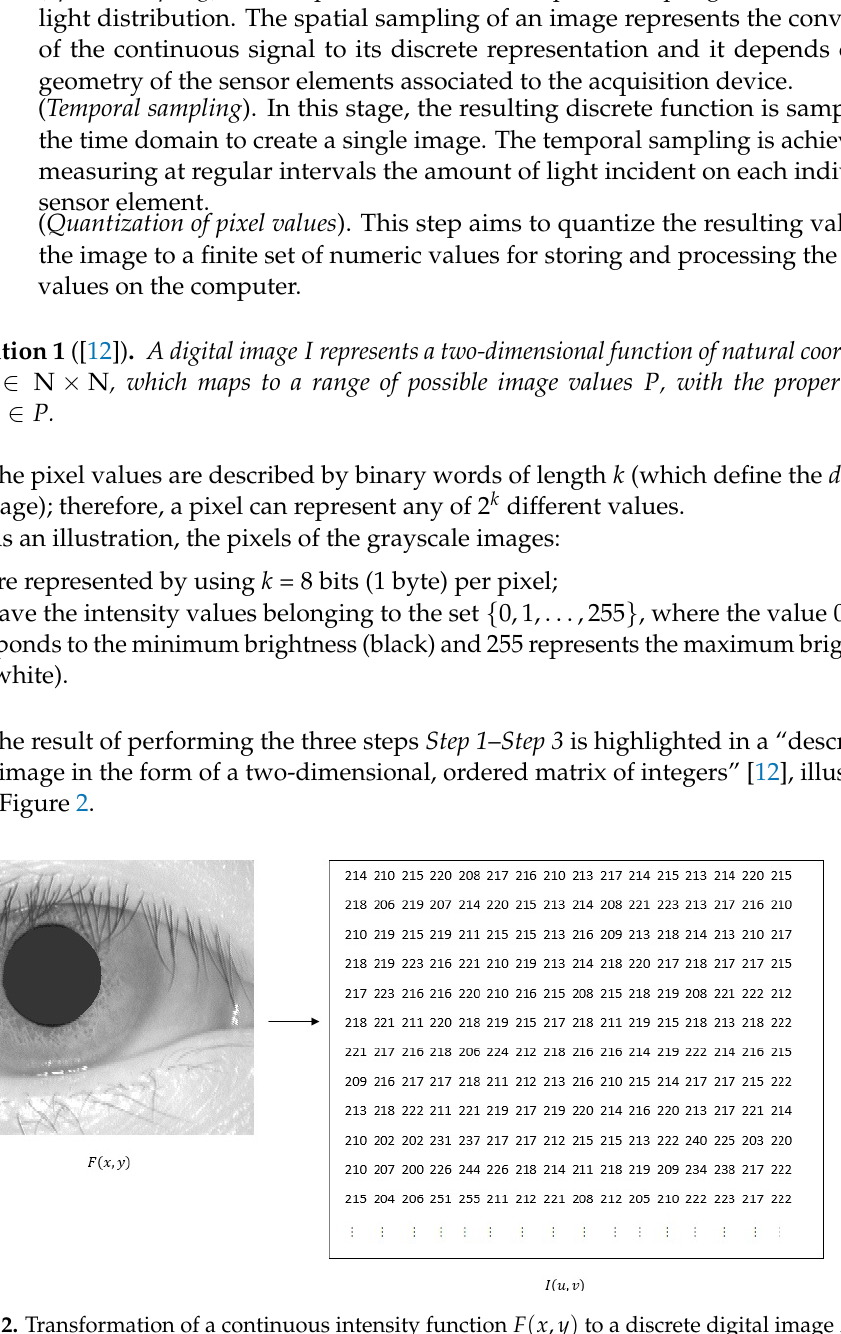
Figure 2. Transformation of a continuous intensity function F ( x , y ) to a discrete digital image F ( u , v ) . CASIA Iris Image Database Ver 3.0 (or CASIA-IrisV3 for short) contains three subsets, totally 22,051 iris images of more than 700